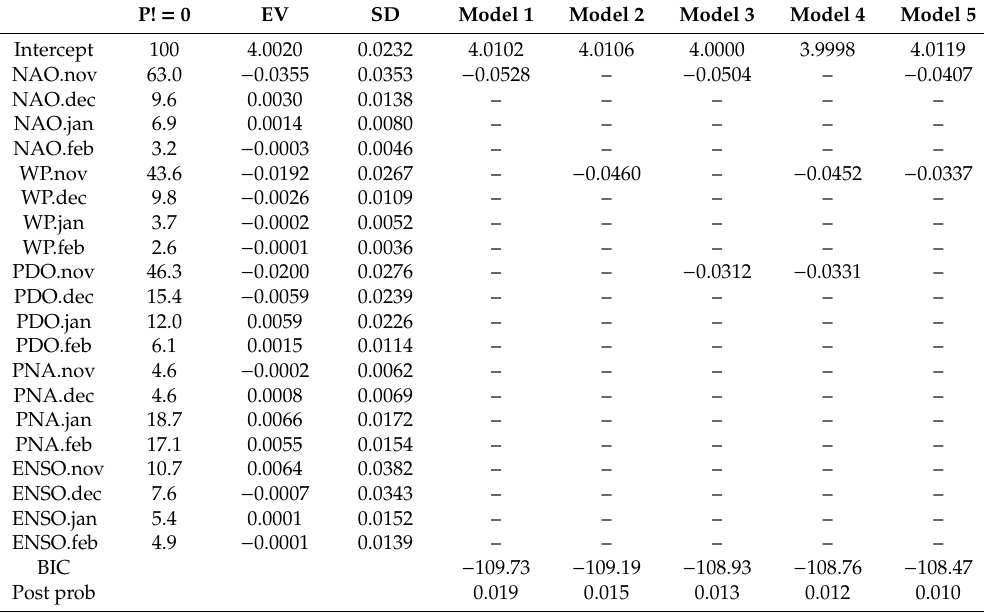
right. The first model is in the left bar, which includes the November NAO covariate. The color bar is blue, which indicates that the probability of Northwest Pacific ETCs decreases with November NAO. The width of the bar is proportional to the posterior probability so the bars become narrow with increasing model number. A covariate that has a more consistent color bar is more important. The fewer the gaps, the more often the covariate is chosen in a model. These included November NAO, November WP, and November PDO. Time series generated by the regression model by the BMA for the ETC counts are shown in Figure 9. The red and blue lines represent the predicted and observed ETCs in winter over the Northwest Pacific, respectively. In addition, we used cross validation to compare the skill of BMA with the skill of other selection procedures. Both selection procedures involved the single best Poisson GLM, where best was defined as the model with the smallest BIC or the model with the smallest AIC [24]. For the BMA and selection procedures, we calculated the mean squared error (MSE), root mean squared error (RMSE), and mean absolute error (MAE) (Table 2), where the smaller the indictors, the more accurate the